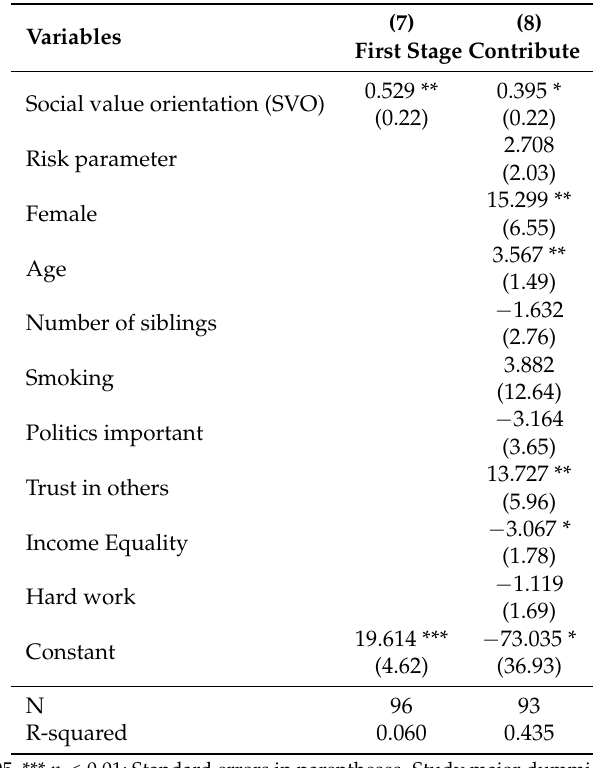
Table A1. Determinants of stage 1 contribution—OLS